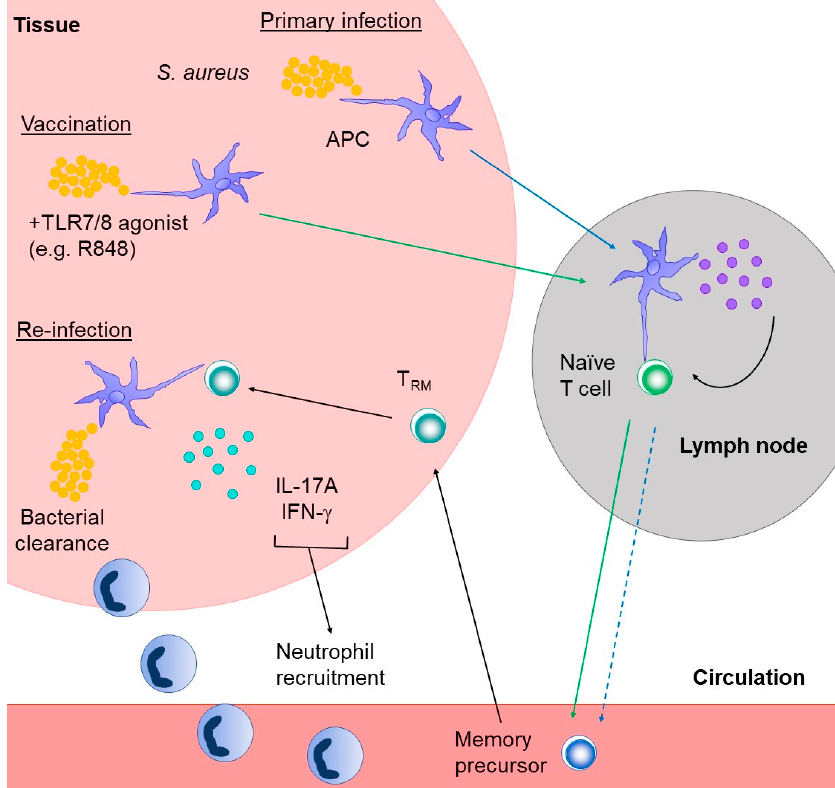
Figure 2. A model for potential roles of T RM in protecting against S. aureus infection. Given the poor induction of long-lasting protective immunity to S. aureus infections, it is possible that natural S. aureus infection (broken blue arrows) fails to lead to the development of T RM cells. Vaccination strategies (green arrows) proven to induce protective T RM responses against another bacterial infection [112] could be employed to promote the induction of protective T RM cells. If generated upon vaccination, S. aureus -specific T RM cells could produce IL-17A and IFN γ leading to neutrophil recruitment and subsequent bacterial clearance upon re-infection of sites such as the skin and soft tissues.